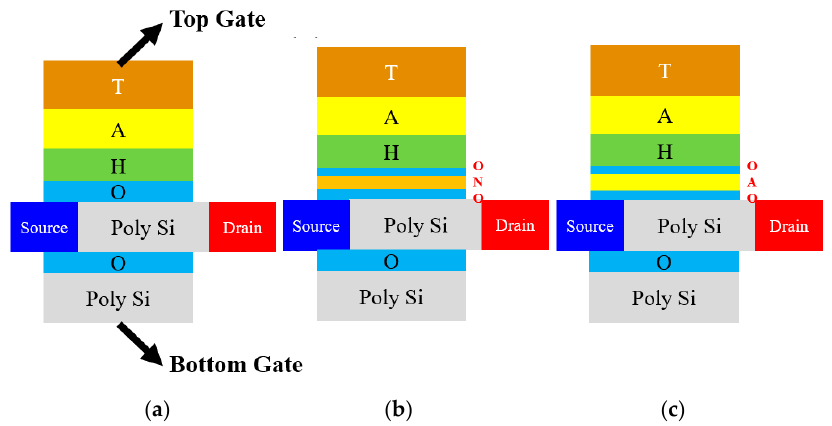
Figure 1. Schematic view illustrating ( a ) conventional TaN/Al 2 O 3 /HfO 2 /SiO 2 /Si (TAHOS), ( b ) bandgap engineered (BE)-TAHOS, and ( c ) proposed TaN/Al 2 O 3 /HfO 2 /SiO 2 /Al 2 O 3 /SiO 2 /Si (TAHOAOS) structure with two gate terminals. All structures commonly have HfO 2 as charge-trapping layer (CTL) and Al 2 O 3 as blocking oxide. The abbreviated letters T, A, H, O, N stand for tantalum nitride (TaN, gate metal), Al 2 O 3 , HfO 2 , SiO 2 , Si 3 N 4 , respectively. Table 1. Film thickness and channel length in conventional TAHOS, BE-TAHOS, and proposed TAHOAOS structure.